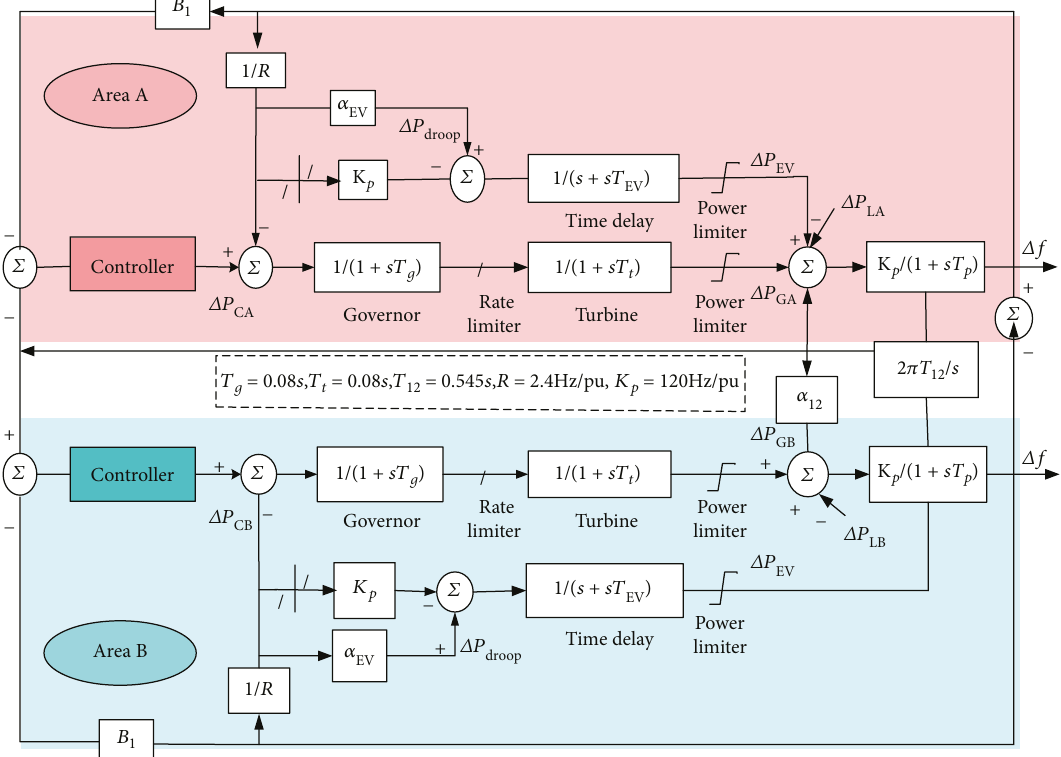
Figure 4: Modi fi ed IEEE two-area LFC power